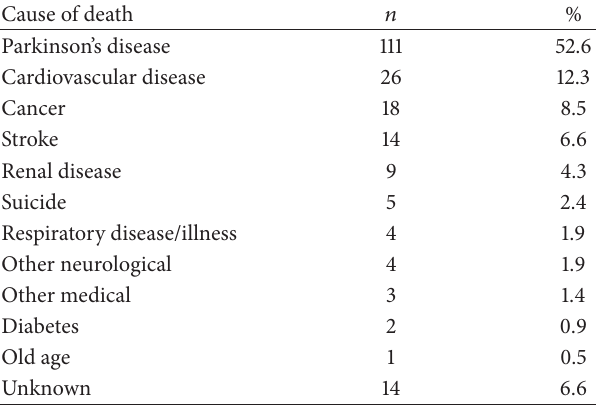
Table 2: Cause of death by clinical impression.